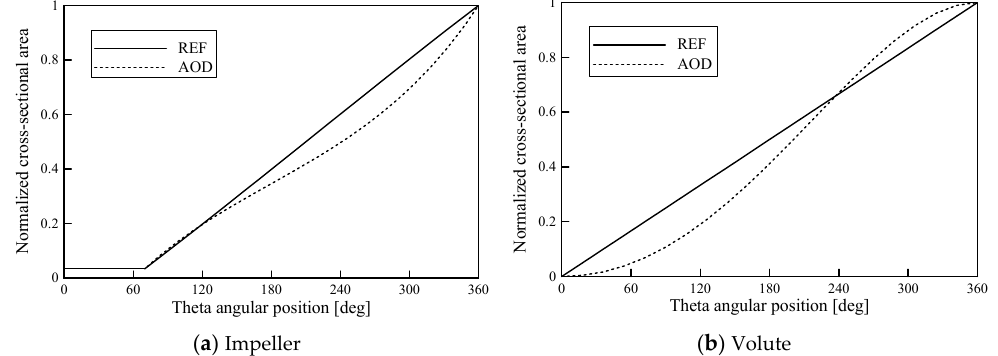
Figure 11. Cross-sectional area distributions of the flow path.